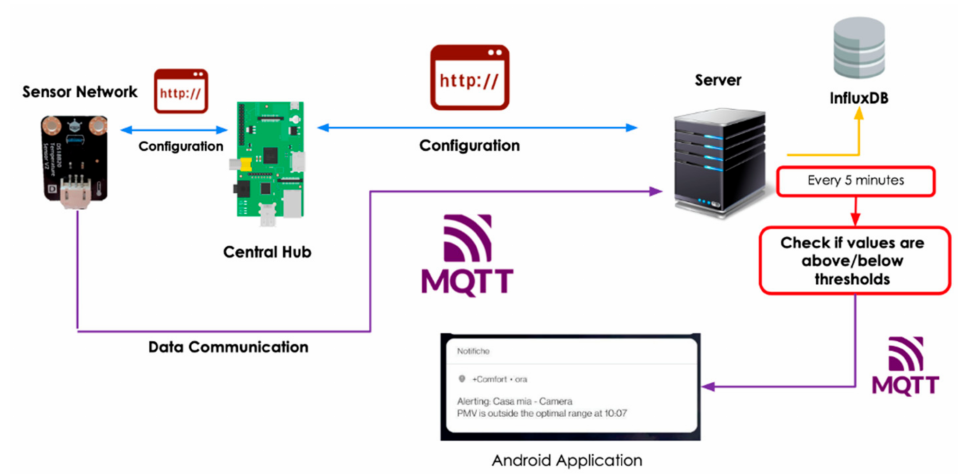
Figure 6. Communication protocols